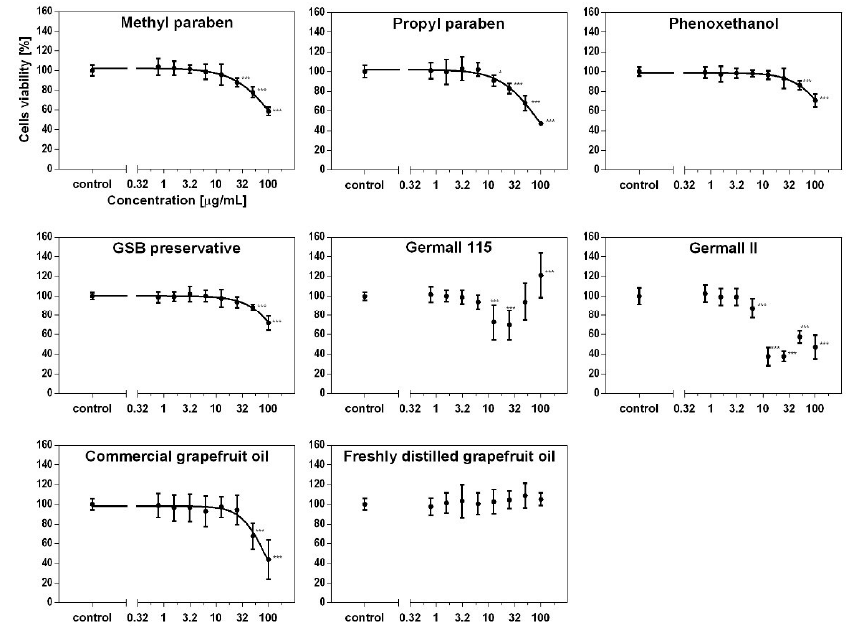
Figure 2. Effect of preservatives on keratinocyte (HaCaT) cells’ viability using MTS test. Each value (mean ± SD) represents the average of cell viability (%) after 24 h incubation; n = 6, one-way ANOVA. *, p < 0.05; ***, p < 0.001.